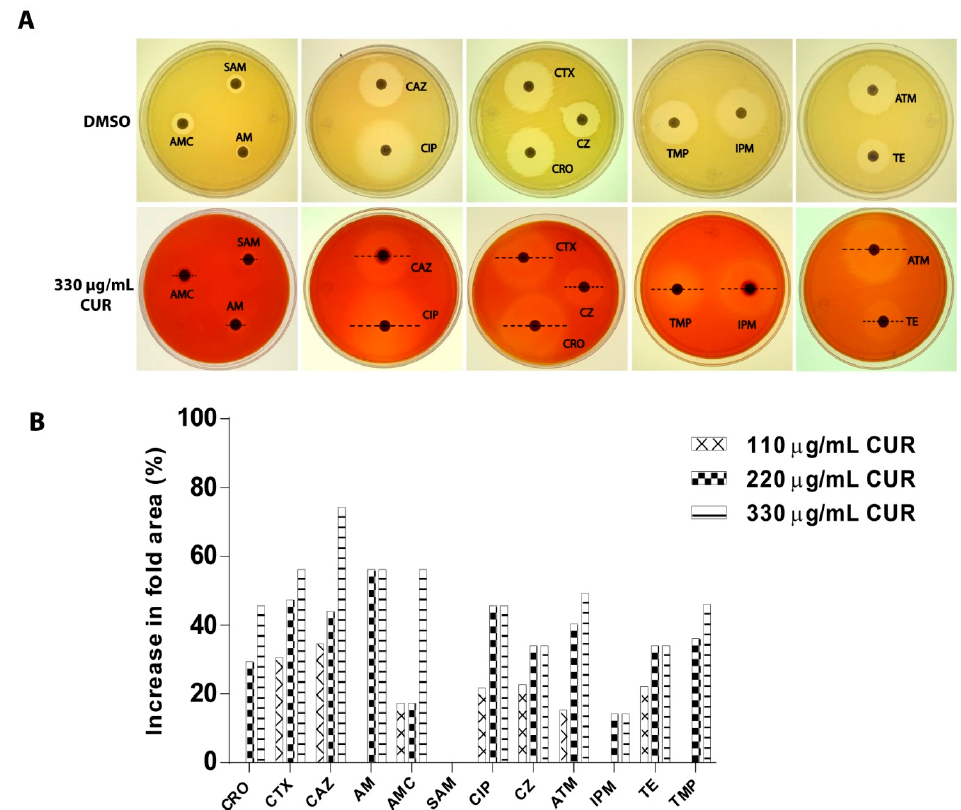
Figure 2. Synergistic effect of curcumin. ( A ) Representative images of susceptibility at different antibiotics against a strain of Enterotoxigenic E. coli (in the absence or presence of curcumin). ( B ) The percent of increases in inhibition area for different antibiotics was calculated as (B 2 − A 2 ) / A 2 × 100, where A is the inhibition zone in the absence of curcumin and B is the inhibition zone in the presence of curcumin. See Table 3 for A and B values.